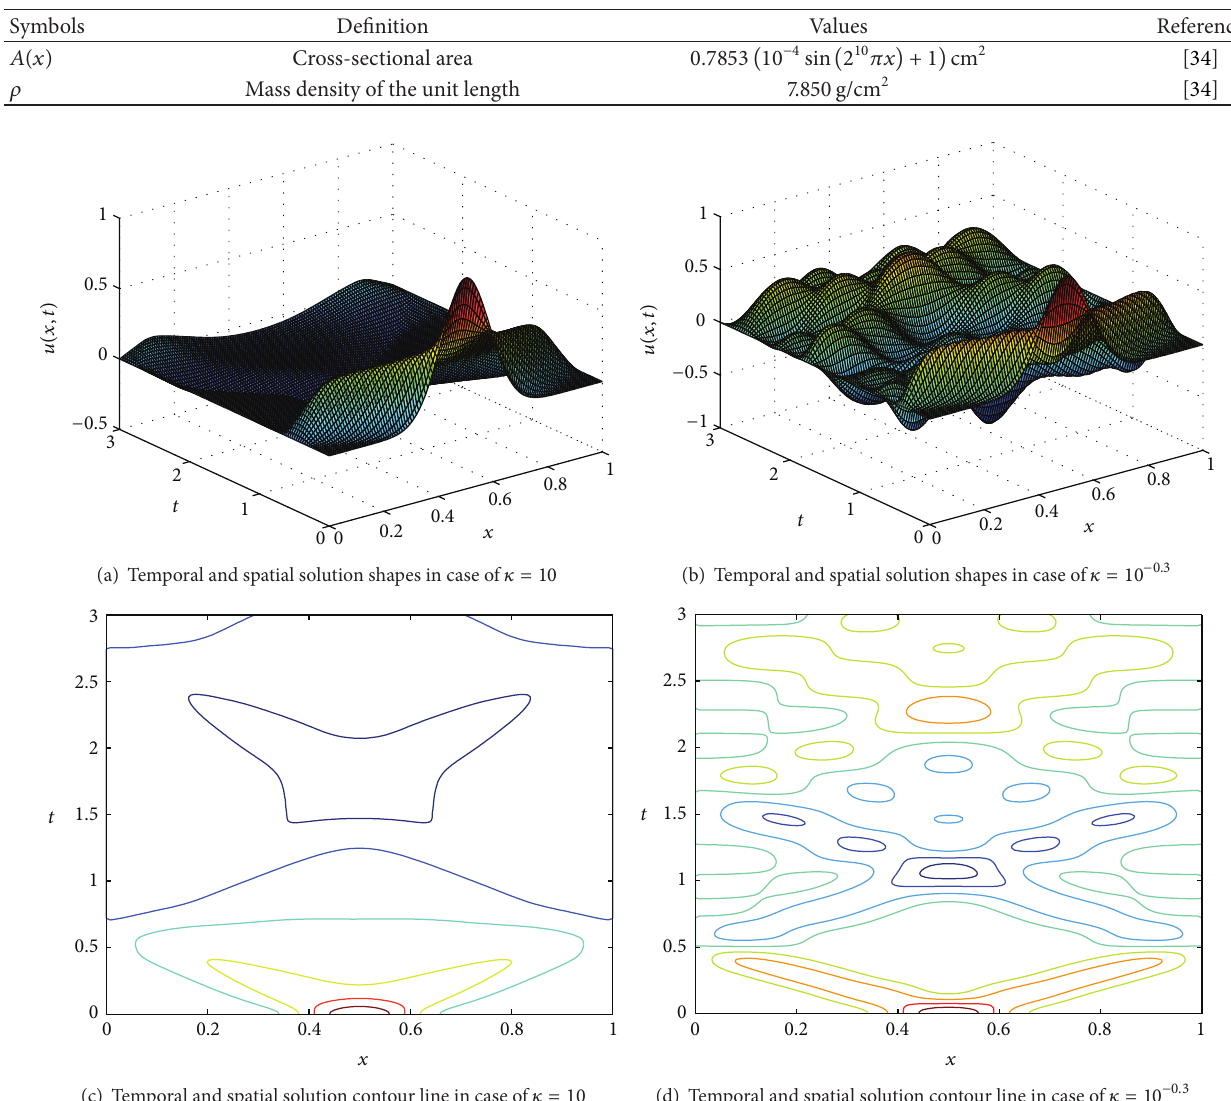
Table 1: Simulation parameters which are satisfied by theoretical conditions.